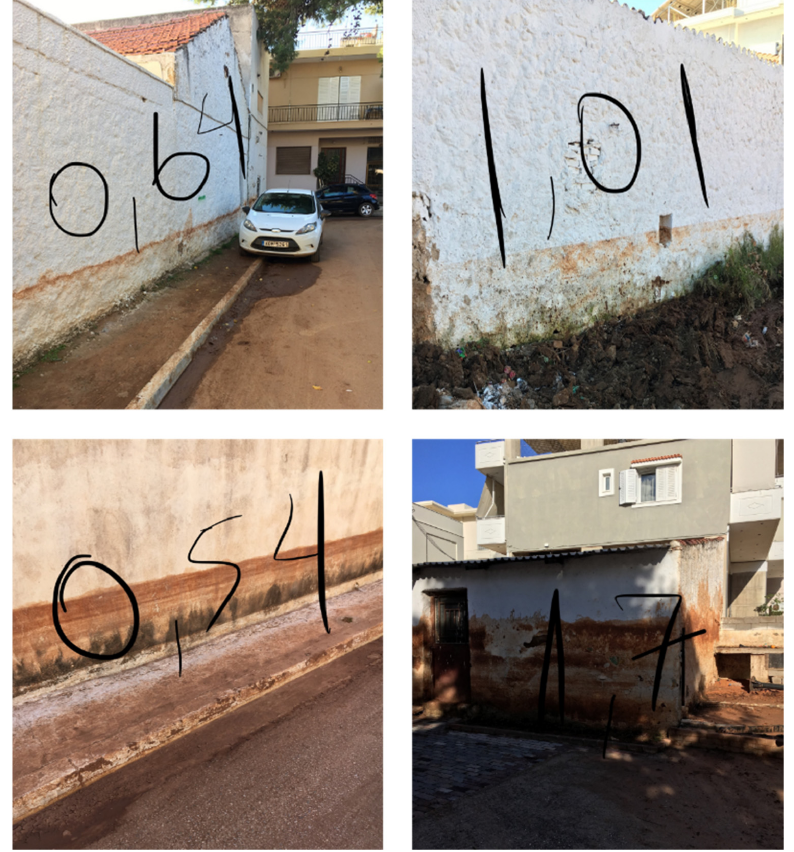
Figure 4. Indicative observation points in Mandra town (in roads): the observed maximum depths are 0.64 m (up & left), 1.01 m (up & right), 0.54 m (down & left), 1.70 (down & right).